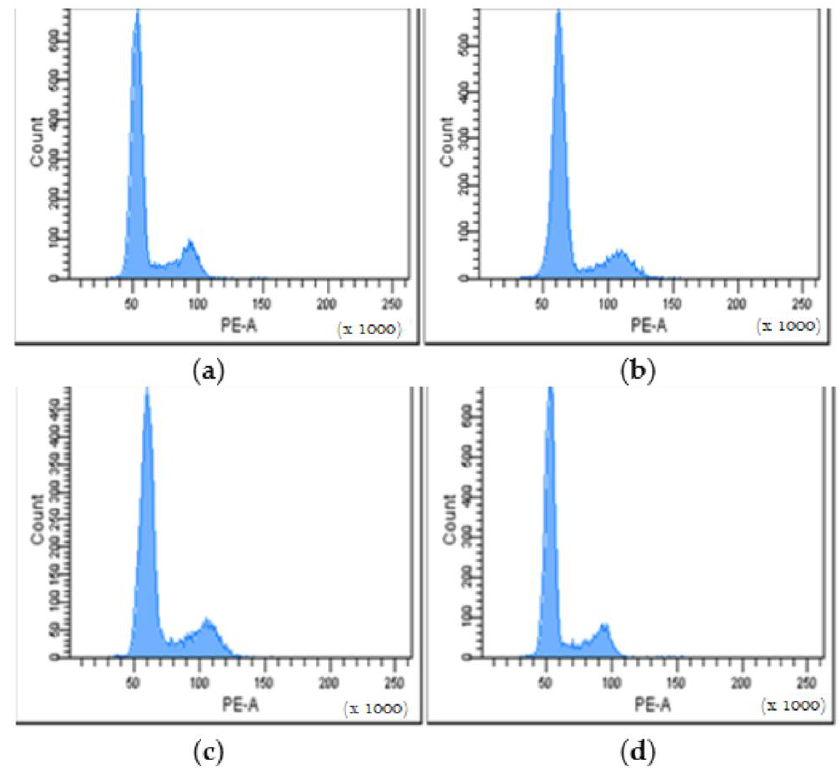
Figure 7. Cell cycle histograms of mouse NCTC fibroblasts treated with different PHBV/BC-based biocomposites for 24 h. Control ( a ); PHBV/Vitamin E ( b ); PHBV/BC1% ( c ); PHBV/BC2% ( d ).